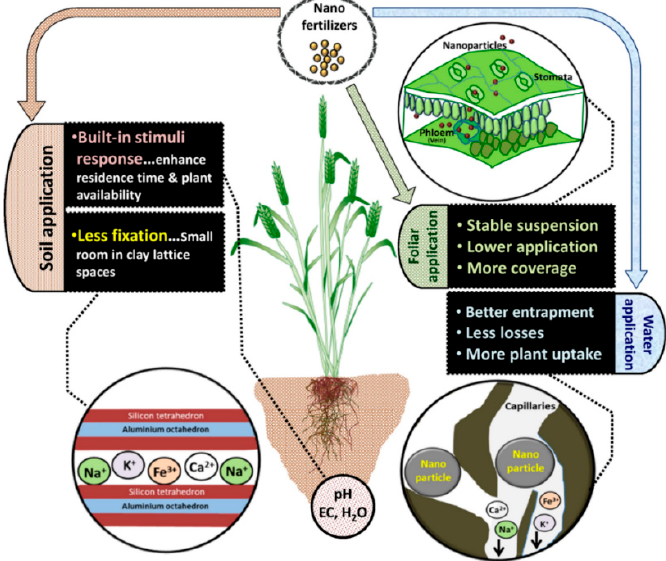
Figure 1. Potential benefits of nanofertilizers under different modes of application for crop production. In [18] under Creative Commons Attribution License (CC BY).